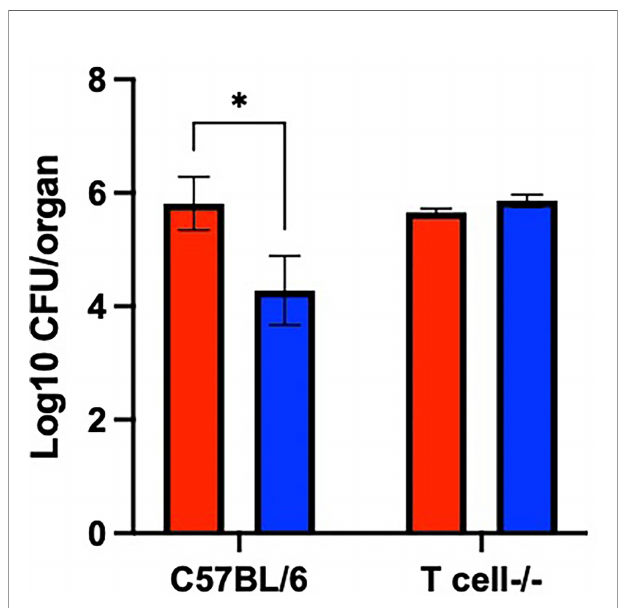
FIGURE 7 | T cell-mediated bacterial clearance is disrupted by PsxA. Log10 of CFU of WT B. pseudohinzii (red) or B. pseudohinzii D psxA (blue) recovered from the middle ears of C57BL/6 or T cell-/- mice at 56 days post inoculation. N=3 per mouse type and bacterial strain, assay was performed in duplicate. Error bars show the standard error of the mean. Statistical signi fi cance was calculated via Two-way ANOVA.